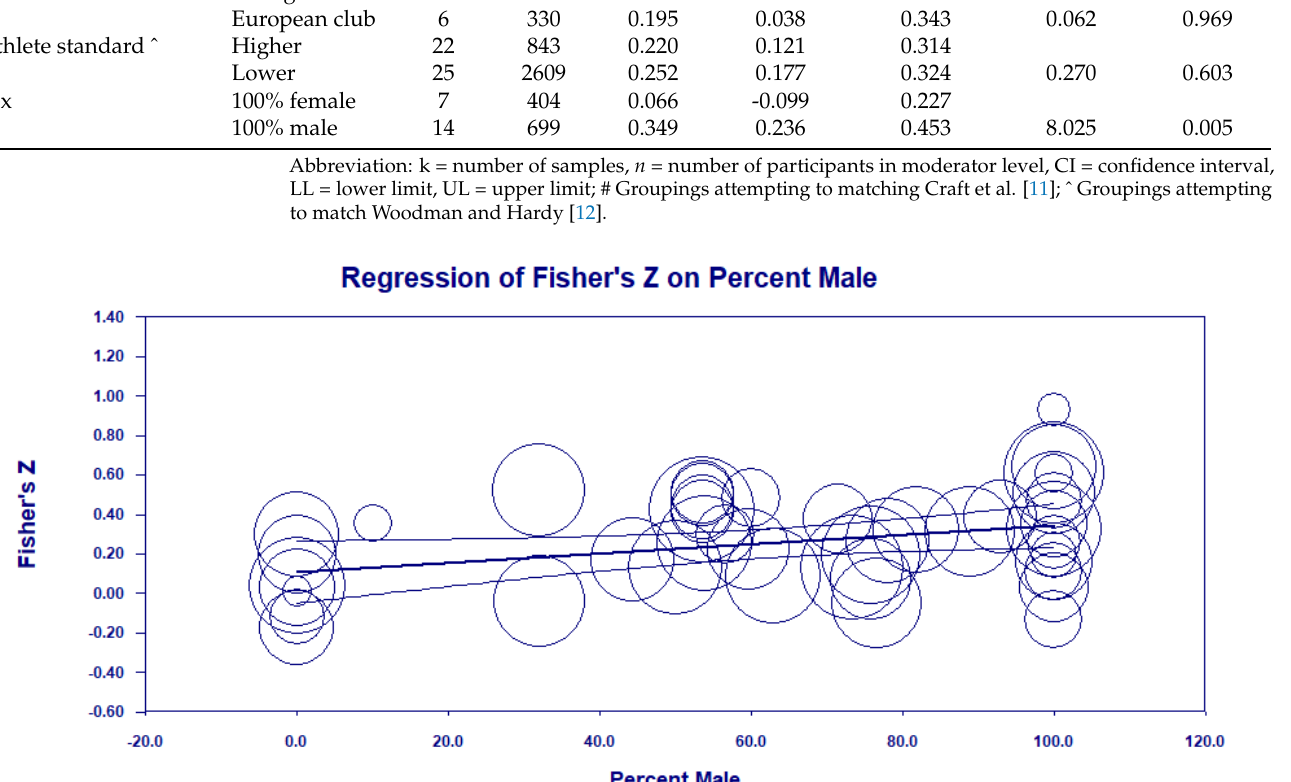
Table 5. Certainty of Results by Research Question.